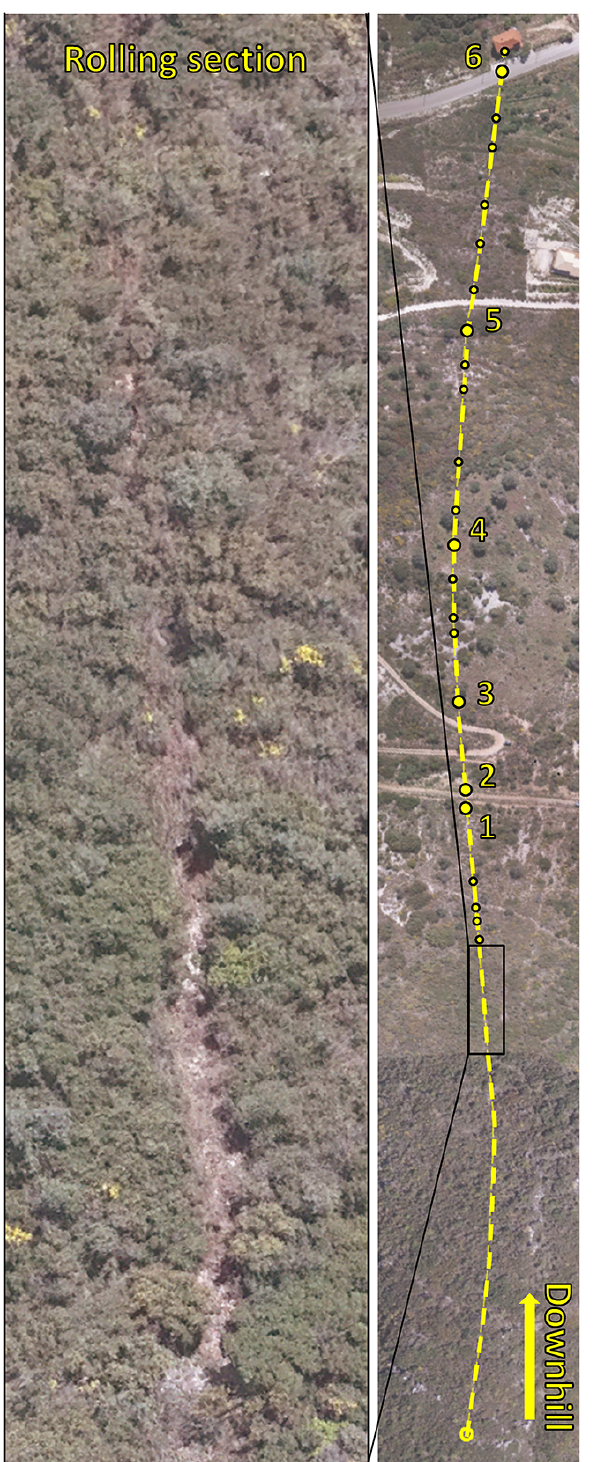
Figure 3. Top view orthophoto – Rolling section and bouncing positions recognition